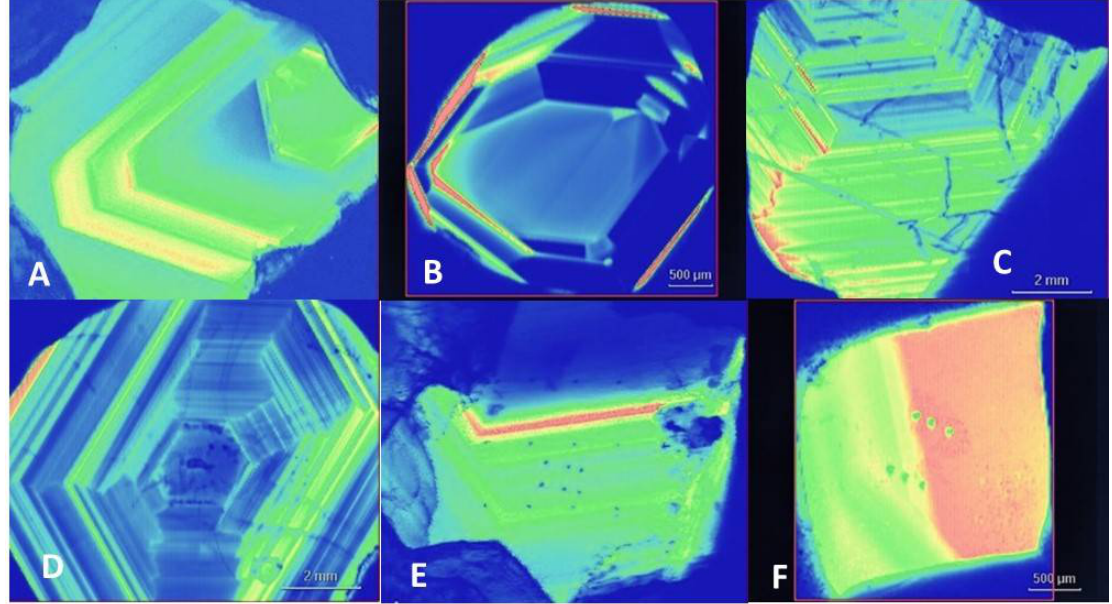
Figure 19. Representative PL maps showing Cr distribution in Sri Lankan sapphires demonstrating ( A – E ) sharp, oscillatory growth patterns, often arranged in hexagonal patterns, as well as ( F ) diffuse variations in Cr concentrations. Note, ( A ) reproduced from [48].